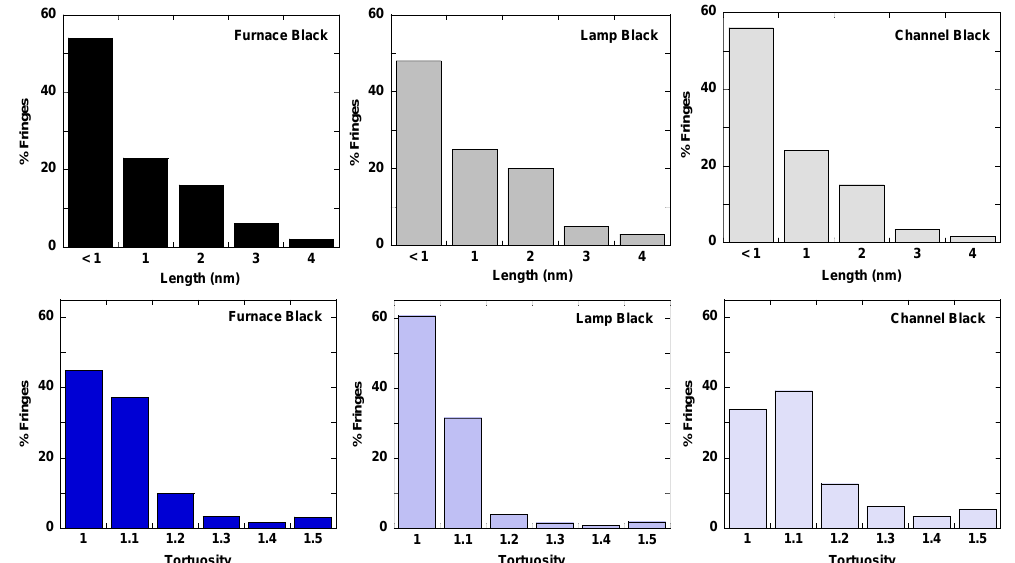
Figure 9. Fringe statistics of ( top ) length and ( bottom ) tortuosity for furnace, lamp, and channel black. C 2018 , 4 , x FOR PEER REVIEW